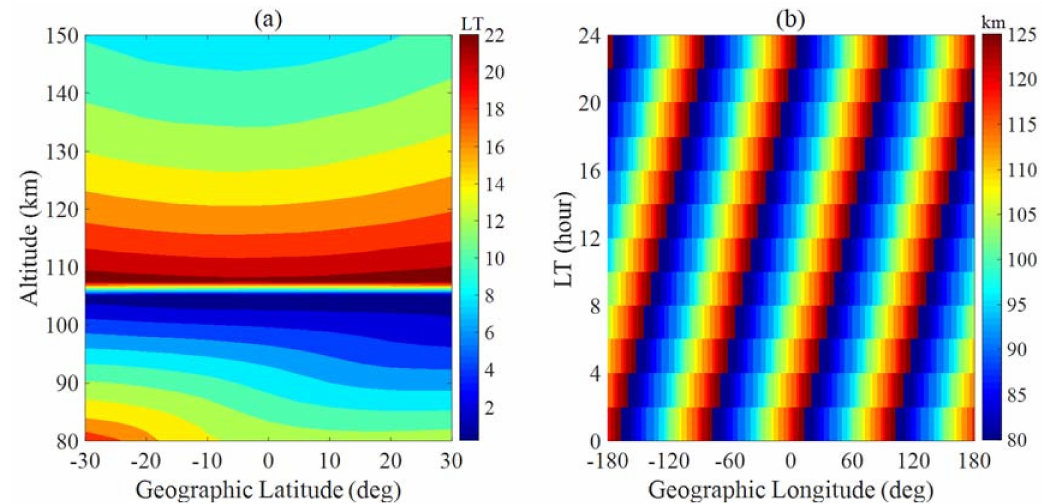
Figure 8. ( a ) The phase distribution of the DE3 tide for the zonal wind in September; ( b ) the altitude distribution of the convergence null for the DE3 tide in the zonal wind in